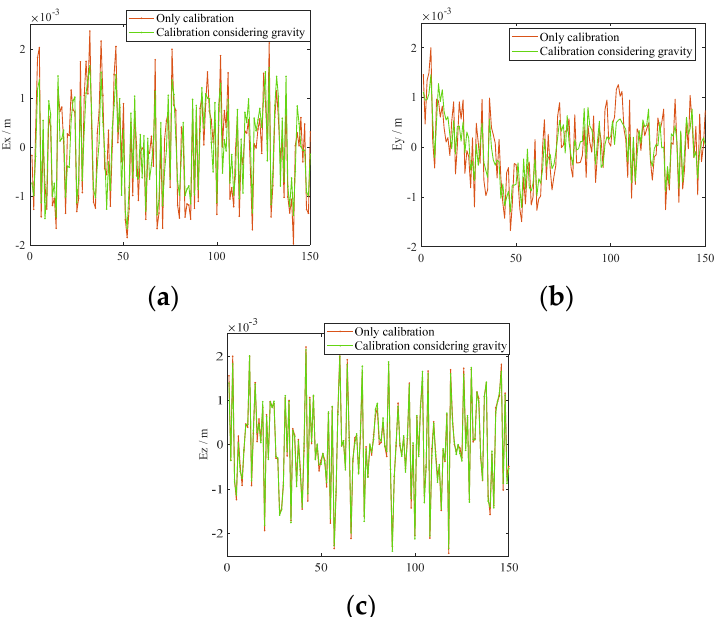
Figure 13. Comparison of gravity compensation and non-compensation in the X- ( a ), Y- ( b ) and Z- ( c ) directions. Table 3. Maximum and mean errors obtained after calibration by various methods.